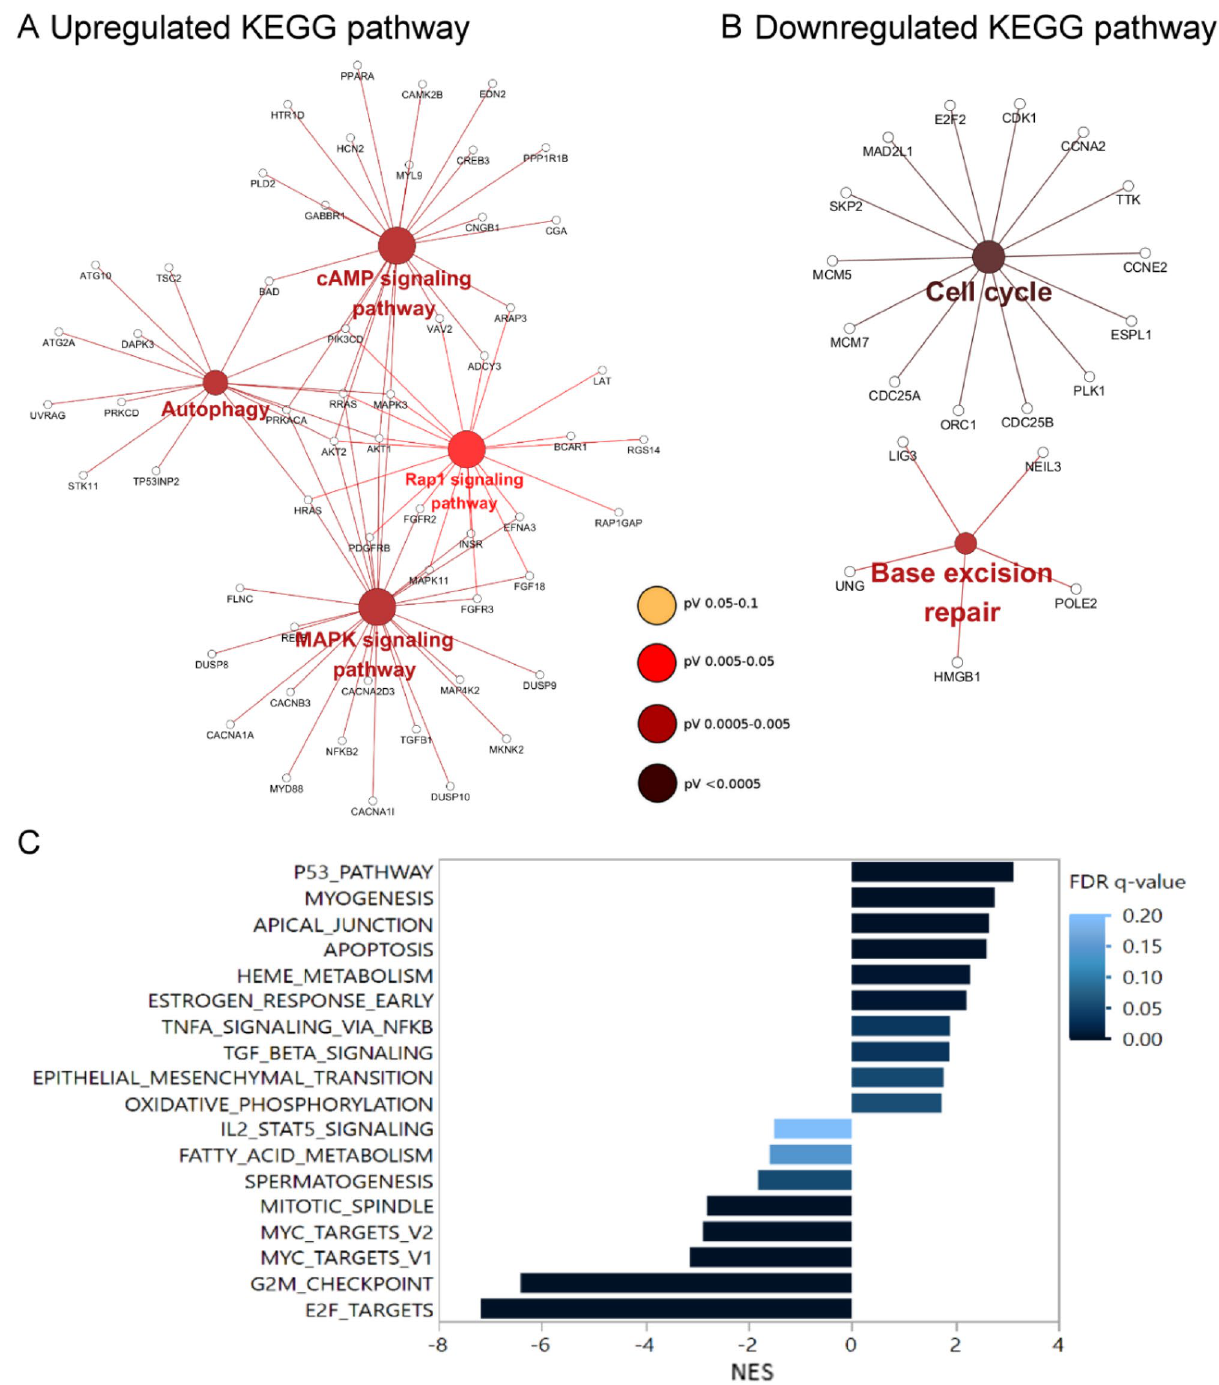
Figure 2. Identification of functional pathways impacted by Zac1 overexpression using Cytoscape ClueGO and GSEA. KEGG pathways associated to upregulated DEGs (A) and downregulated DEGs (B) with mZac1 overexpression. Large circles represent correlated pathways and small circles indicate differentially expressed genes in the pathways. (C) Normalized enrichment scores (NES) of the enriched Hallmark gene-sets ( P < 0.01, FDR < 0.2) associated with mZac1 overexpression in HeLa